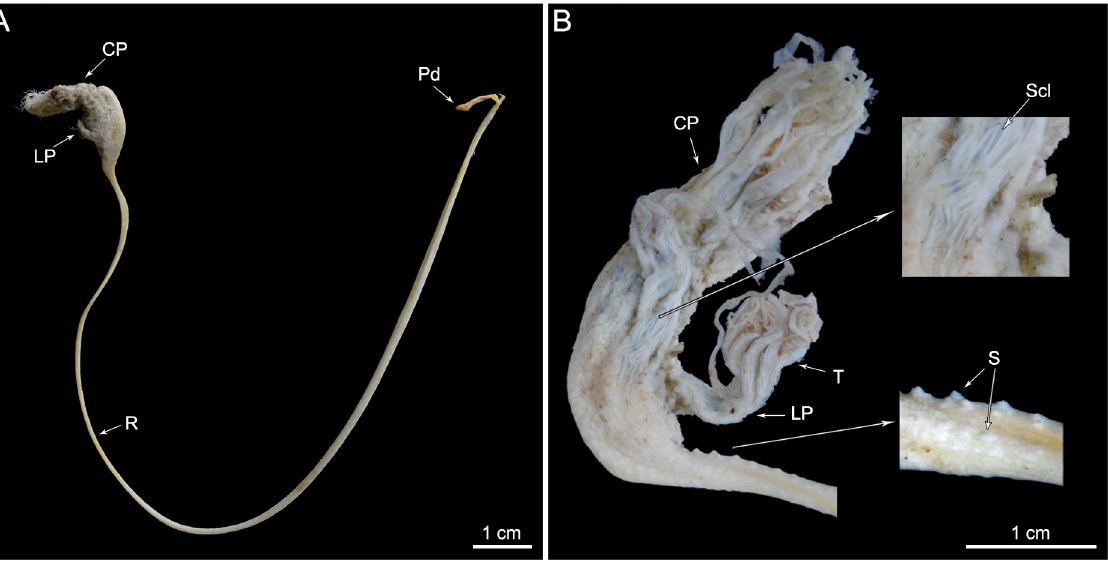
Fig. 2. A. General aspect of Umbellula pomona Risaro, Williams & Lauretta sp. nov. A . Holotype (MACN-IN 42608). B . Detail of the terminal cluster of paratype A (MACN-IN 42609), showing three autozooids that form the terminal cluster and amplifications of sclerites (up) and siphonozooids (down). Abbreviations: CP = central polyp; LP = lateral polyp; Pd = peduncle; R = rachis; T = tentacle; S = siphonozooids; Scl = sclerites.